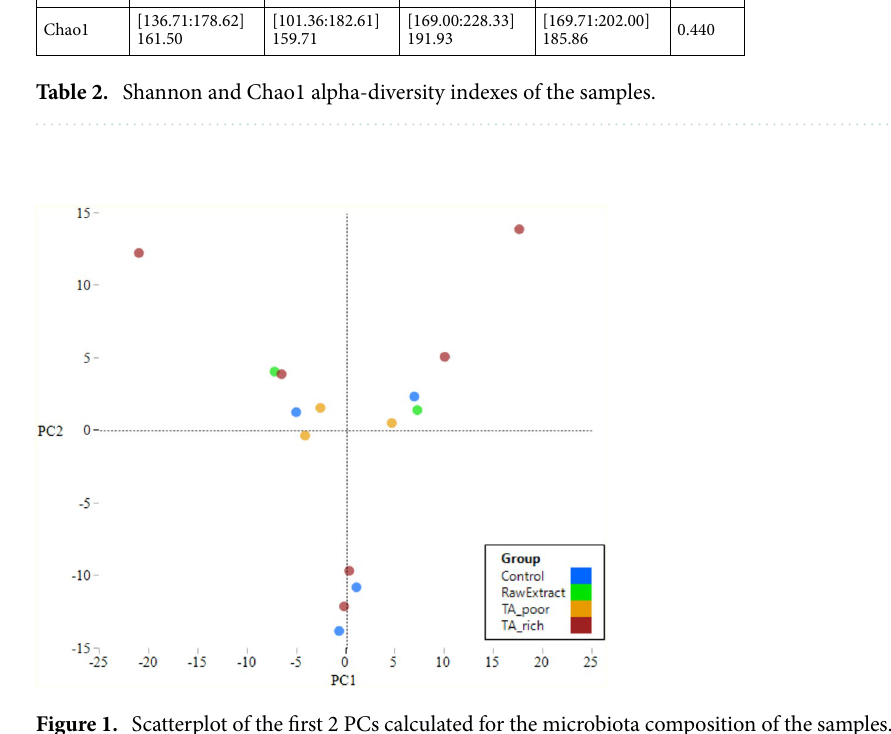
Figure 1. Scatterplot of the first 2 PCs calculated for the microbiota composition of the